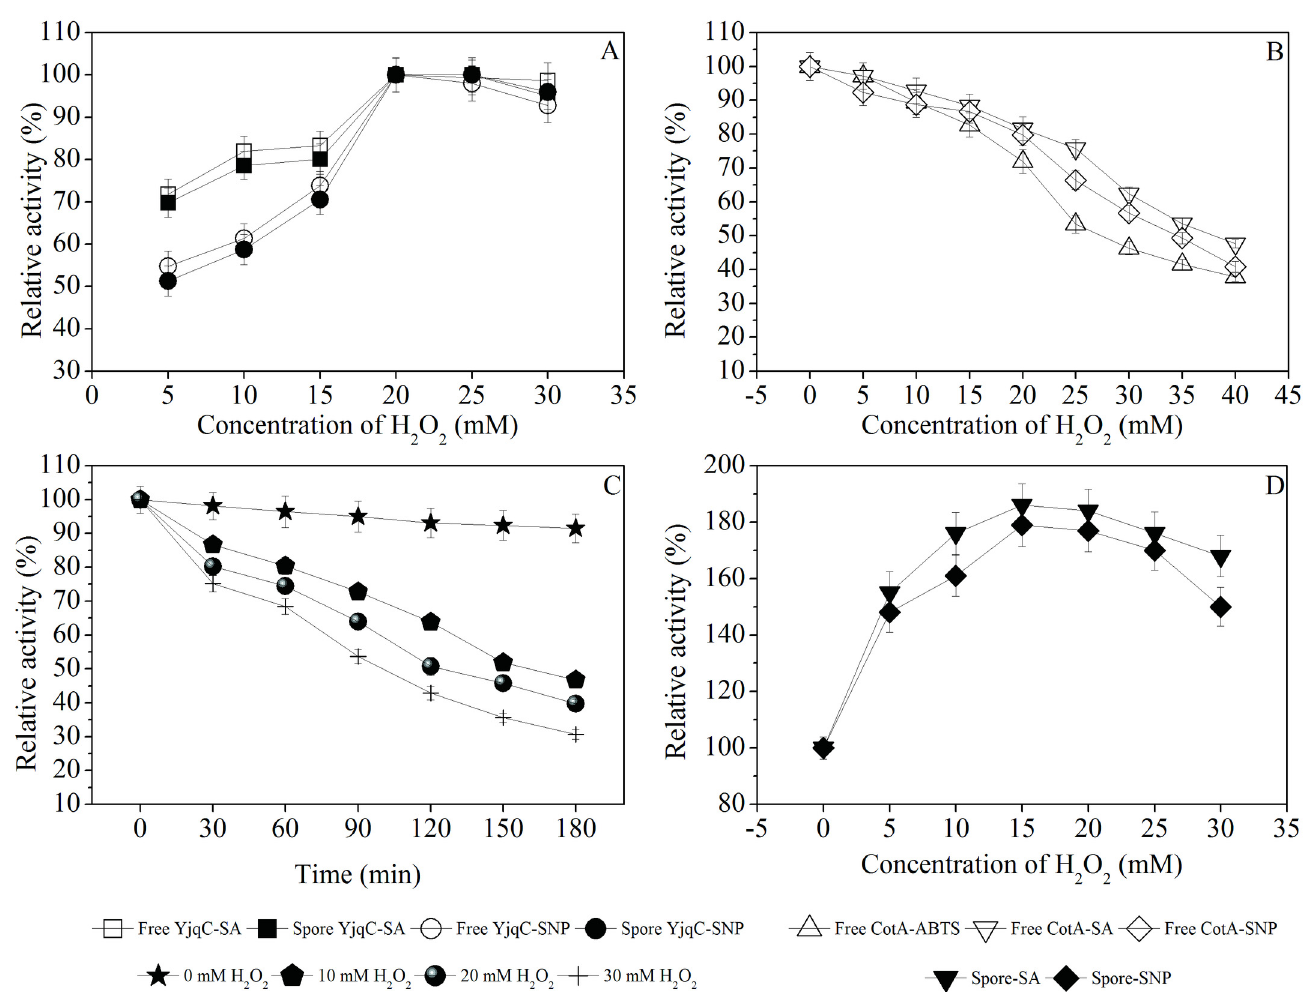
Fig 5. Effects of H 2 O 2 concentrations on activity of YjqC and CotA from B . altitudinis hb4. (A) Variable H 2 O 2 effects on peroxidase activity from the free and spore YjqC. (B) Inhibition by H 2 O 2 of CotA activity toward ABTS, SA and SNP. (C) Stability of CotA incubated with different concentrations of H 2 O 2 for 0 – 180 min. (D) Effects of H 2 O 2 concentrations on enzymatic activity of spore enzymes toward SA and SNP.